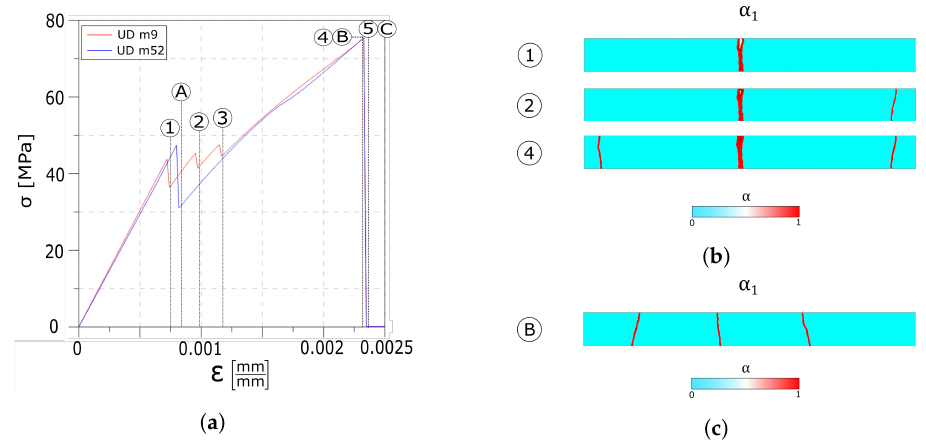
Figure 7. Numerical results: ( a ) Global stress–strain response. ( b ) UD m9 crack evolution overview in the first layer. ( c ) UD m52 crack evolution overview in the first